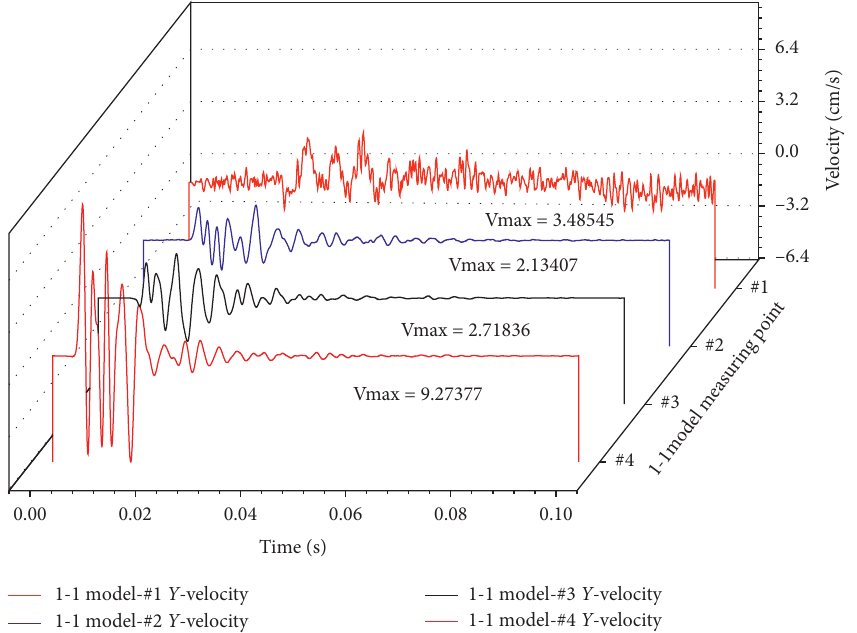
Figure 8: Vibration time history curves of the 1-1 Model for the #1, #2, #3, and #4 measuring points in the Y significantly smaller, and the PPV at the top of the tower is top of the lighthouse. From the source of the explosion to the greater than the PPV at the foot of the lighthouse. All the direction of the lighthouse, the PPV is reduced in turn, models were calculated in turn, and the vibration data of the especially the PPV before and after the damping ditch is